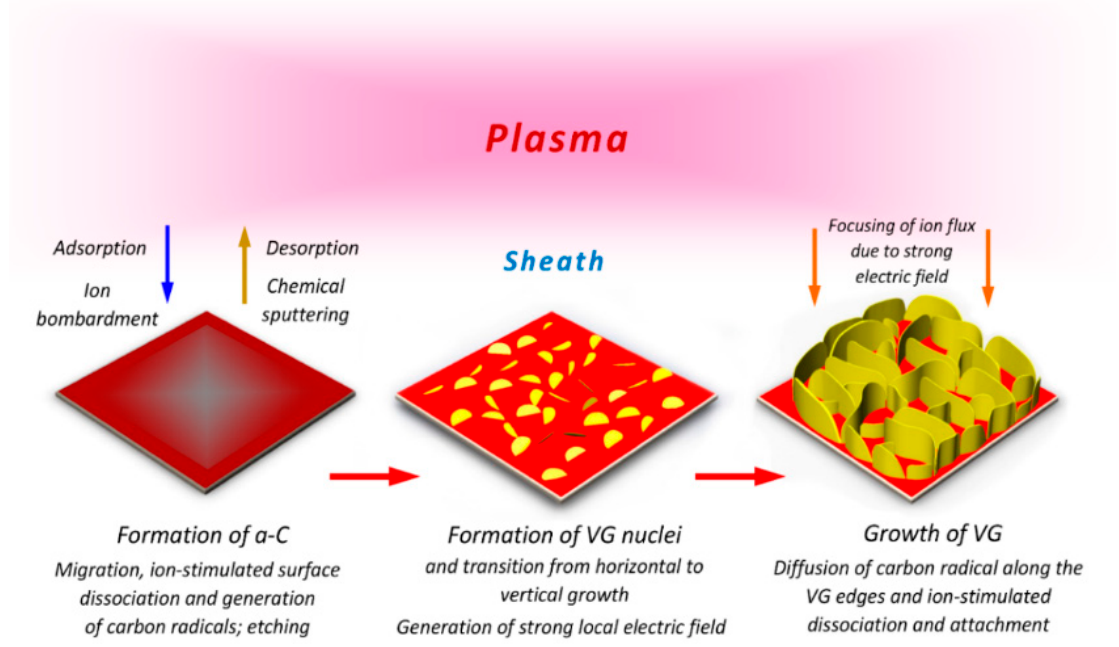
Figure 3. Schematic diagram of a plasma-enhanced deposition.